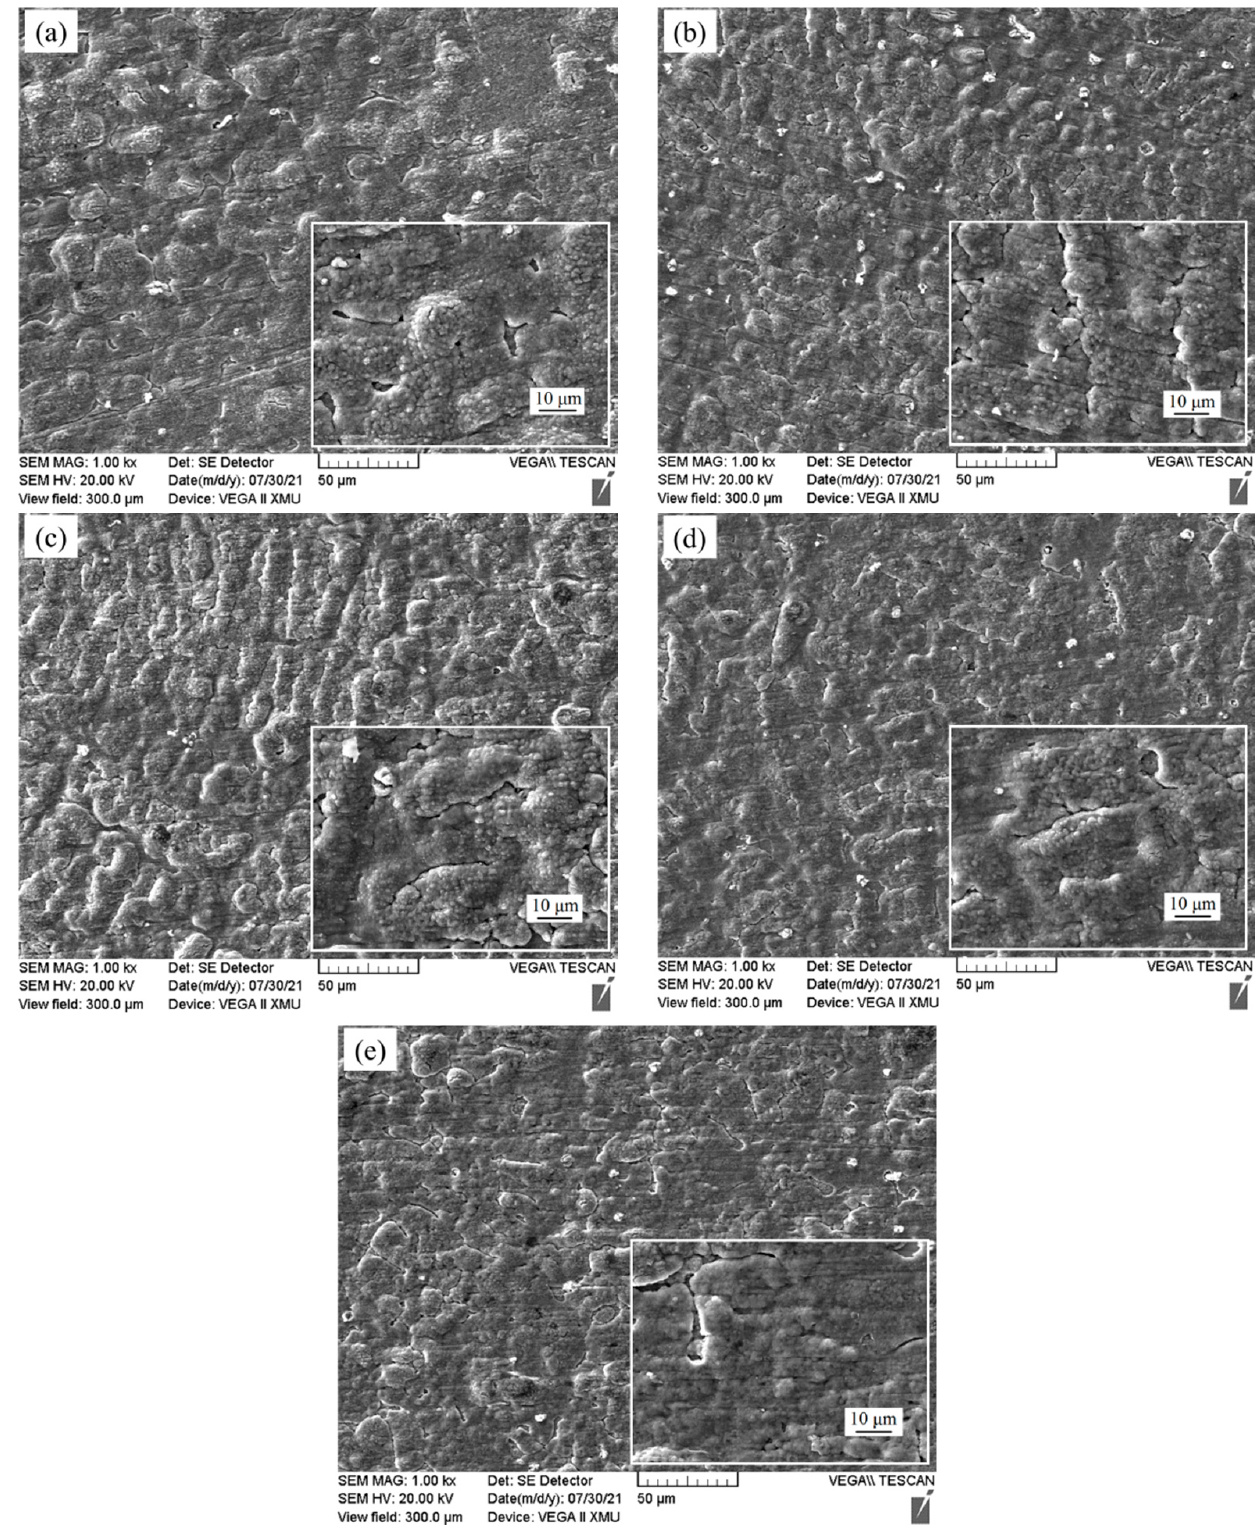
Figure 9. Surface morphology of Fe-25Mn-9Al-8Ni-1C-xTi alloy after 30 h oxidation. ( a ) 0 wt.% Ti; ( b ) 0.1 wt.% Ti; ( c ) 0.2 wt.% Ti; ( d ) 0.3 wt.% Ti; ( e ) 0.4 wt.% Ti.